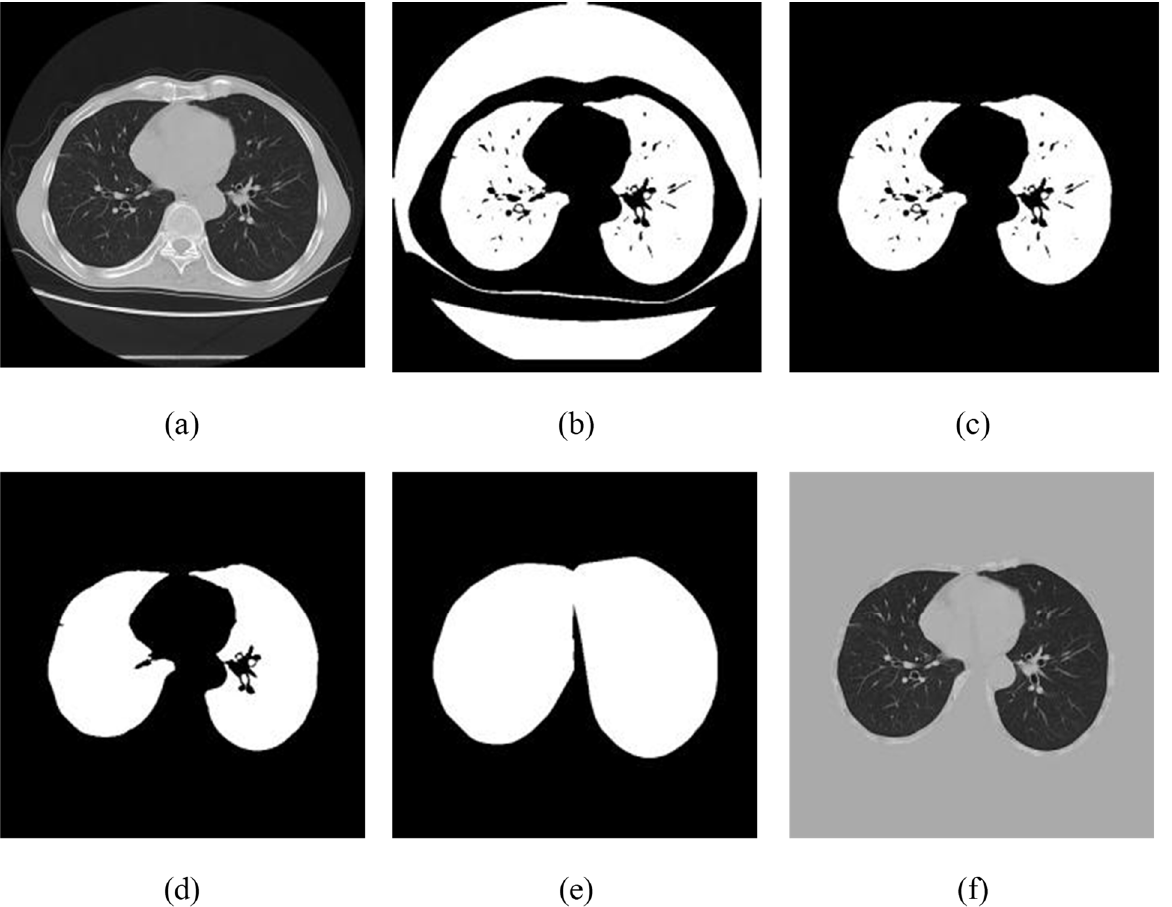
Figure 3. Resulting images of the preprocessing steps: ( a ) re-sampling of CT images with normalization; ( b ) CT image binarization with HU threshold ~600 estimated; ( c ) after the separation of unrelated areas; ( d ) after the application of erosion and dispersion operation; ( e ) mask construction on the image via convex hull operation; ( f ) fusing image of ( a ) and mask ( e ) to generate a valid pulmonary region.